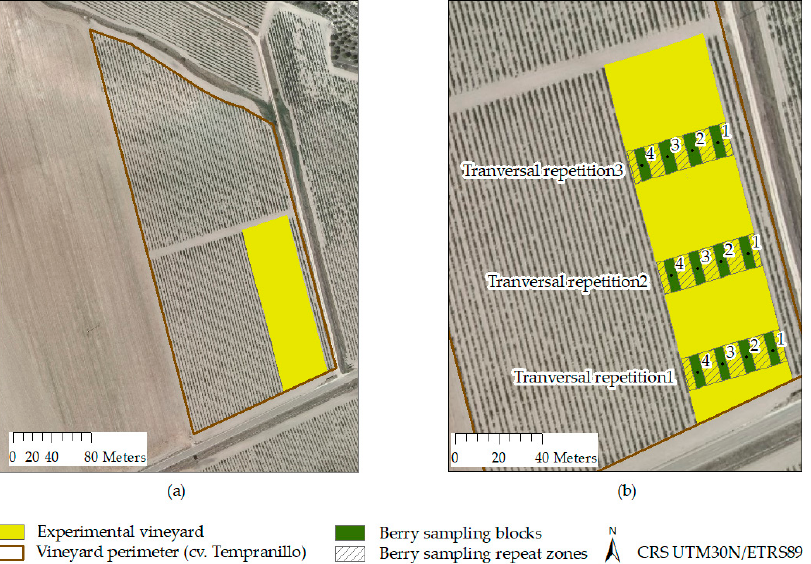
Figure 3. Finca Martinete vineyard (cv. Tempranillo; Olivares del Duero, Valladolid, Spain). ( a ) Vineyard with experi- mental area. ( b ) Sampling blocks and repeat zones. From each of the 12 sampling blocks, 34 of the most representative berries were sam- pled, for a total of 408 berries per block, then stored in labeled bags for refrigerated quality variables described in Table 1. The samples were georeferenced using a Global Navigation Satellite System (GNSS) receiver (Leica Viva GNSS GS08 Plus, LEICA Geosys- tems AG). Table 1. Fifteen laboratory-analyzed must quality variables.